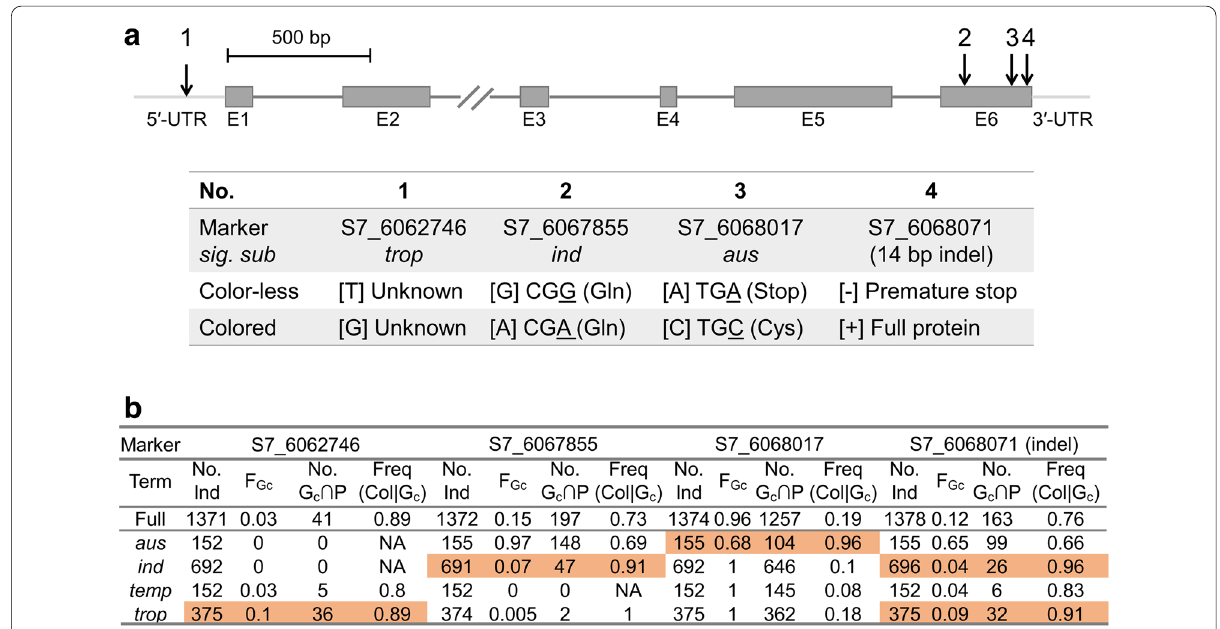
Fig. 7 Relationship between genotype and phenotype for seed coat/pericarp color‑associated SNP inside or close to the known candidate gene Rc . a Position of the SNPs were indicated by arrows on the diagram of the structure of Rc . E1 to E6 stand for exon 1 to exon 6. The gene structure of Rc is proportional to the actual base‑pair length, except for intron 2 which is ca. 2.7 kb. sig. sub indicates the sub‑population from which the corresponding seed coat color‑associated SNP was identified. The color‑less or colored seed coat‑associated allele, as well as the associated functional alteration were indicated. b For each trait‑associated marker, its number of individuals used for the calculation of frequency of individuals carrying the “colored” genotype (F Gc ), the number of individuals carrying the “colored” genotype which had seed coat color information (No. G c and the frequency that the individuals carrying colored genotype had indeed colored seed coat (Freq(Col | G c )). Within a sub‑population, SNPs whose alleles correspond well to phenotypes are highlighted in orange. Meanwhile, only SNP exceeding 20 are